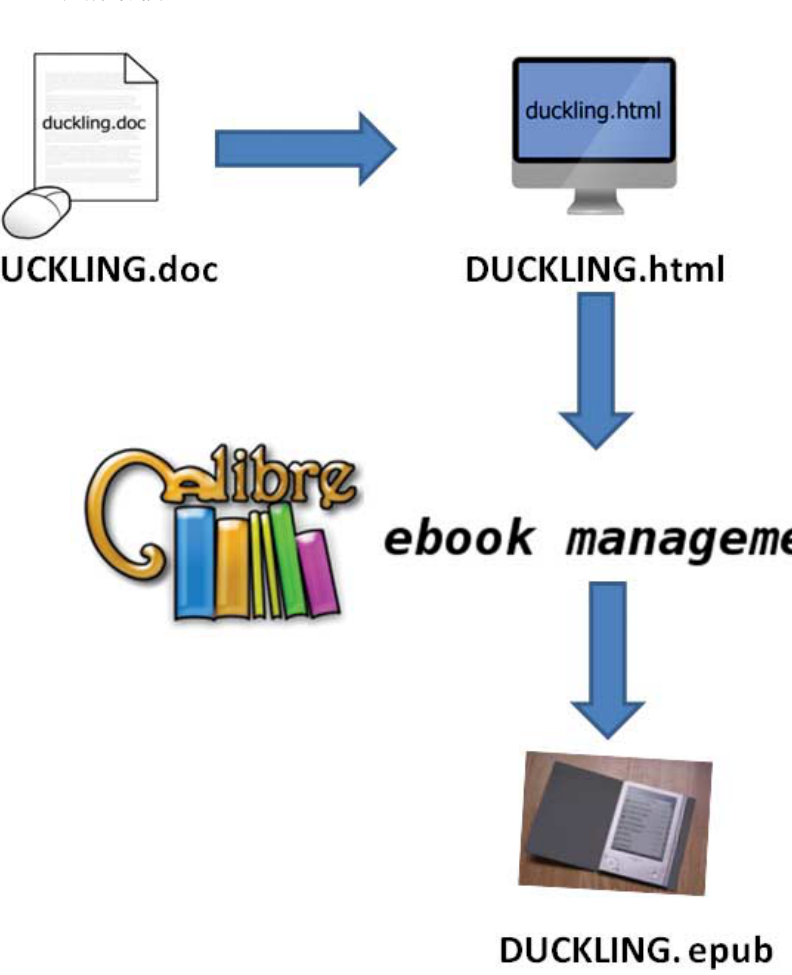
Figure 1. Turning a Word document into ePub